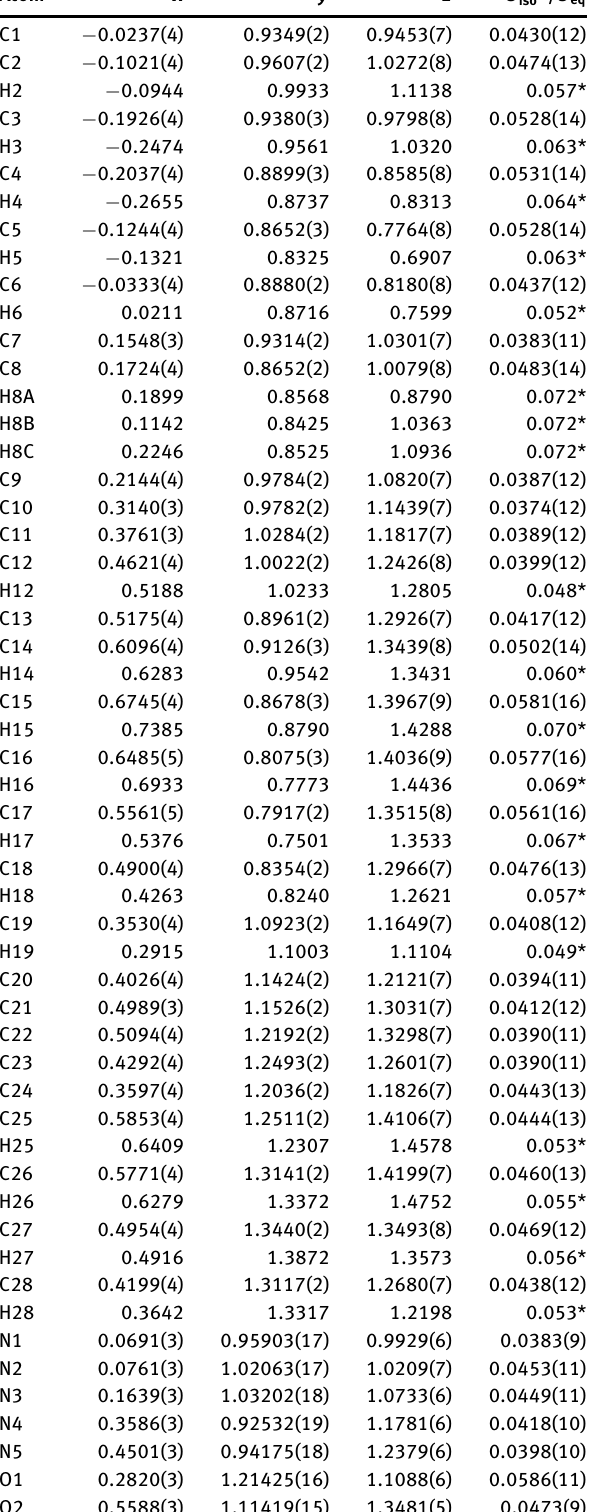
Table 2: Fractional atomic coordinates and isotropic or equivalent isotropic displacement parameters (Å 2 ).